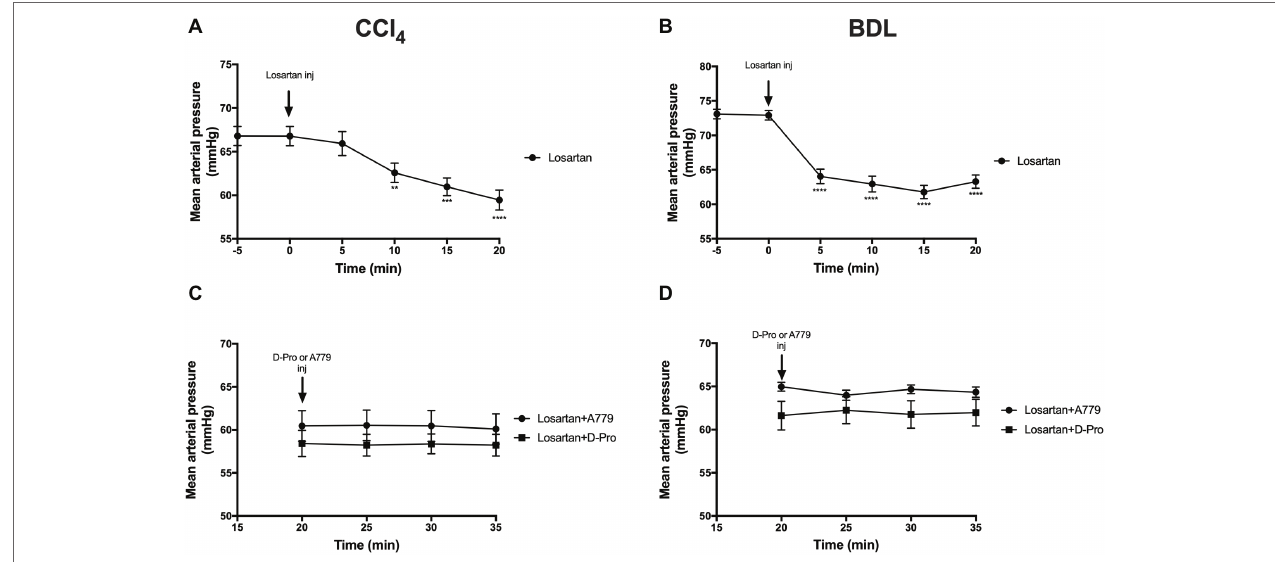
FIGURE 5 | Changes in mean arterial pressure after the treatment with AT1R blocker losartan (1 mg/kg) in the CCl 4 (A) and BDL (B) models. Note that the two groups that received losartan injections in each model were pooled for t-test analysis. Bottom panels show mean arterial pressure of the two losartan groups after receiving either MasR blocker A779 (10 μ g/kg) or MrgD blocker D-Pro (10 μ g/kg) in the CCl 4 (C) and BDL (D) models. Losartan significantly reduced MAP in all groups; however, A779 or D-Pro which was given 20 min after losartan failed to counteract the hypotensive effect of losartan. Each time point represents the mean ± SEM profile from 12 to 14 (A,B) or 6 to 7 (C,D) rats per treatment group. Data in (C) and (D) were analyzed by repeated-measures ANOVA. ** p < 0.01, *** p < 0.001, **** p < 0.0005 baseline vs. post-losartan